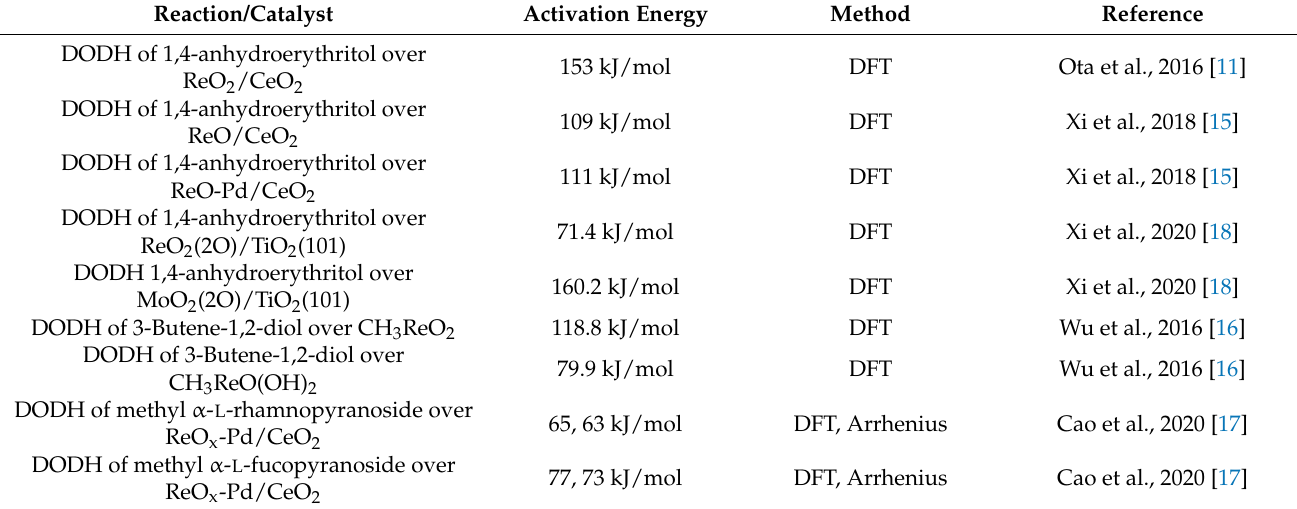
Table 1. Literature activation energies for similar deoxydehydration (DODH)